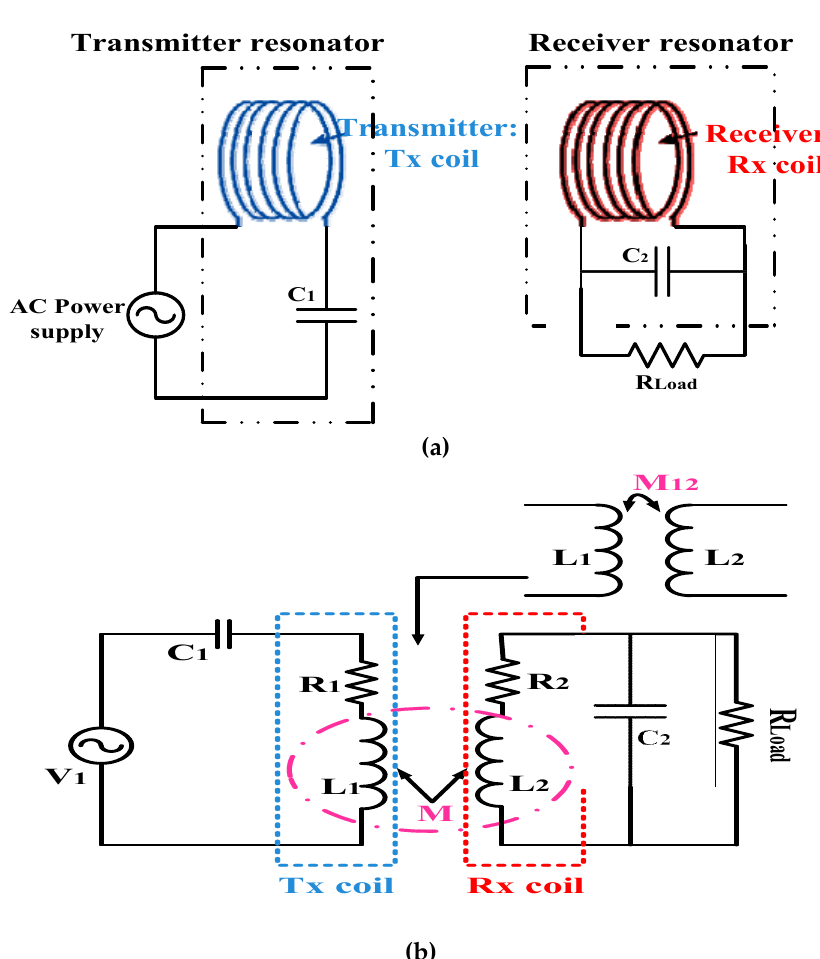
Figure 4. The serial-parallel (SP) resonant topology used in the proposed system. ( a ) Simplified model; ( b ) electrical model.